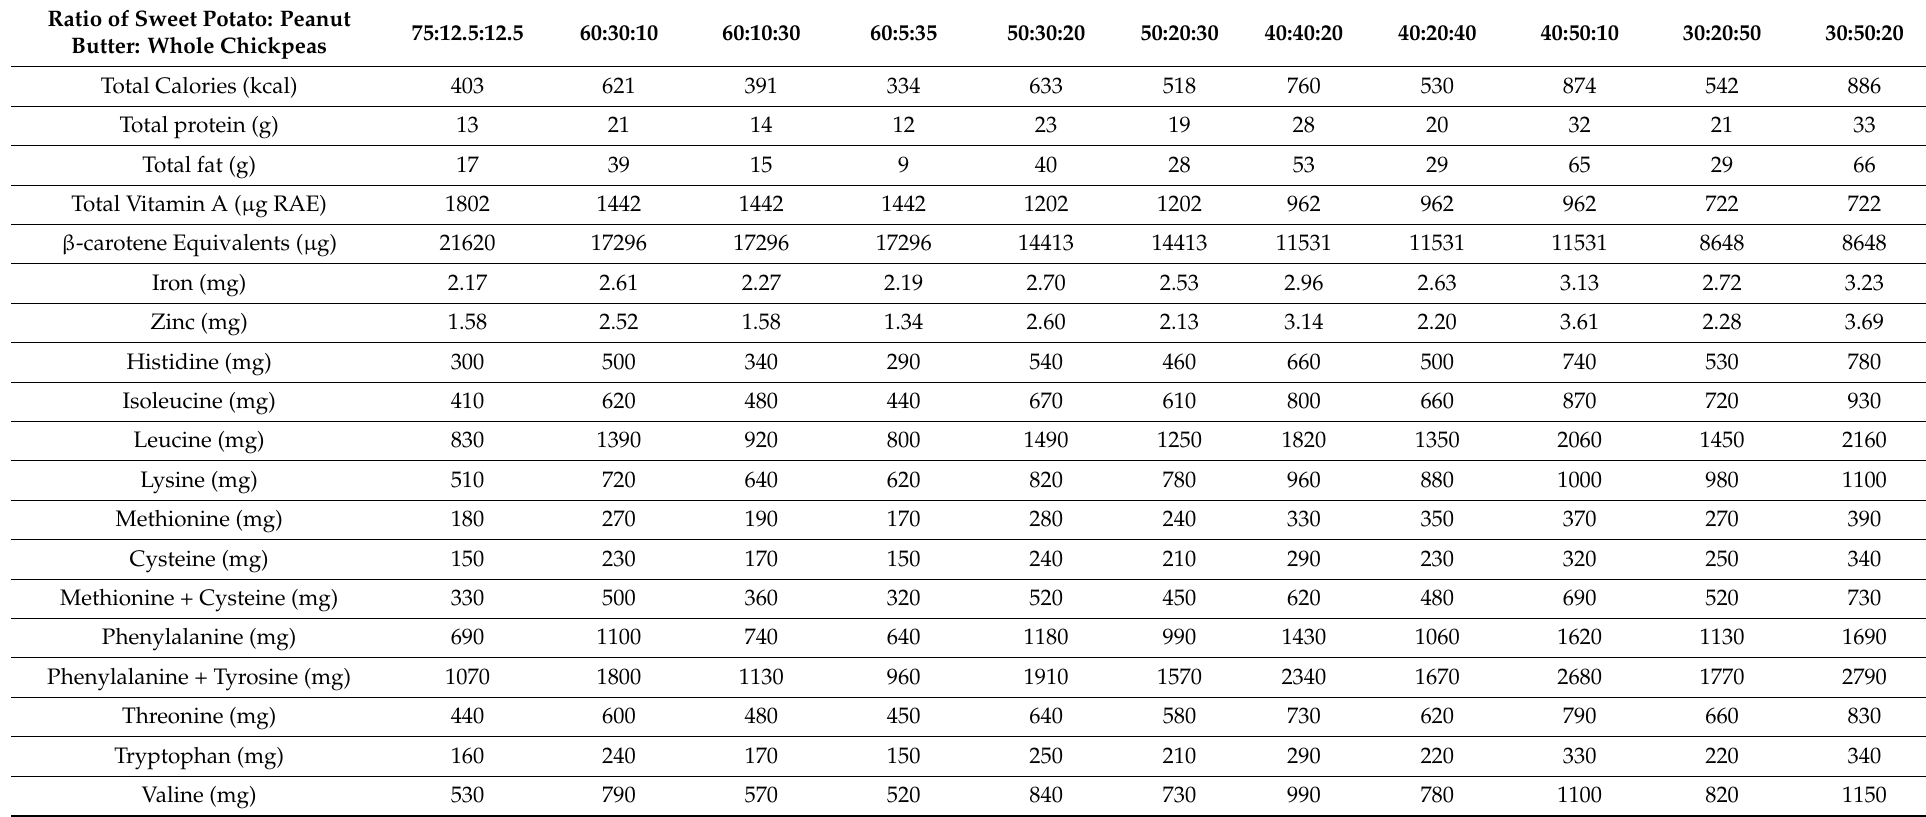
Table 1. Nutrient content of product formulations using The Food Processor Nutrition and Fitness